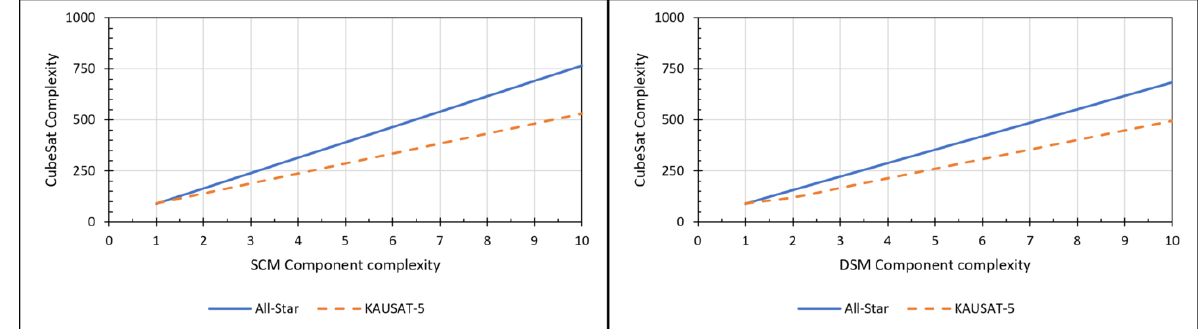
Figure 9. Impact of component complexity, α i , on cubesat complexity with the SysML Complexity metric ( left ) and the DSM Complexity metric ( right ).